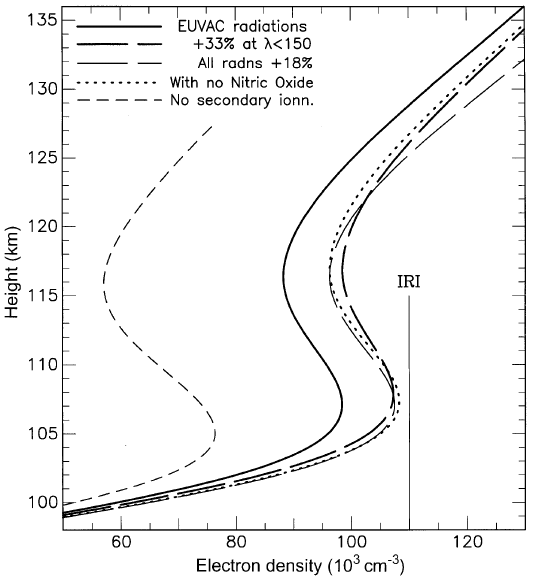
Fig. 5. E-region profiles calculated for summer conditions at 40 ° N, with (cid:115) " 60 ° and F (cid:49)(cid:48)(cid:46)(cid:55) " 120. All curves use the EUVAC radiation model of Richards et al . (1994), and current values for the ionisation cross-sections (from Fennelly and Torr, 1992)